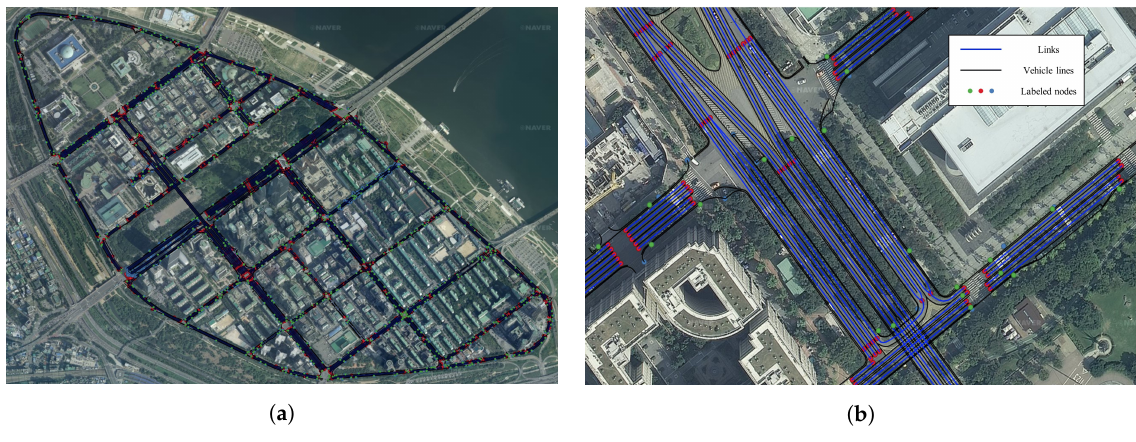
Figure 2. Example of precise roadmap: ( a ) precise roadmap in urban area; ( b ) magnified